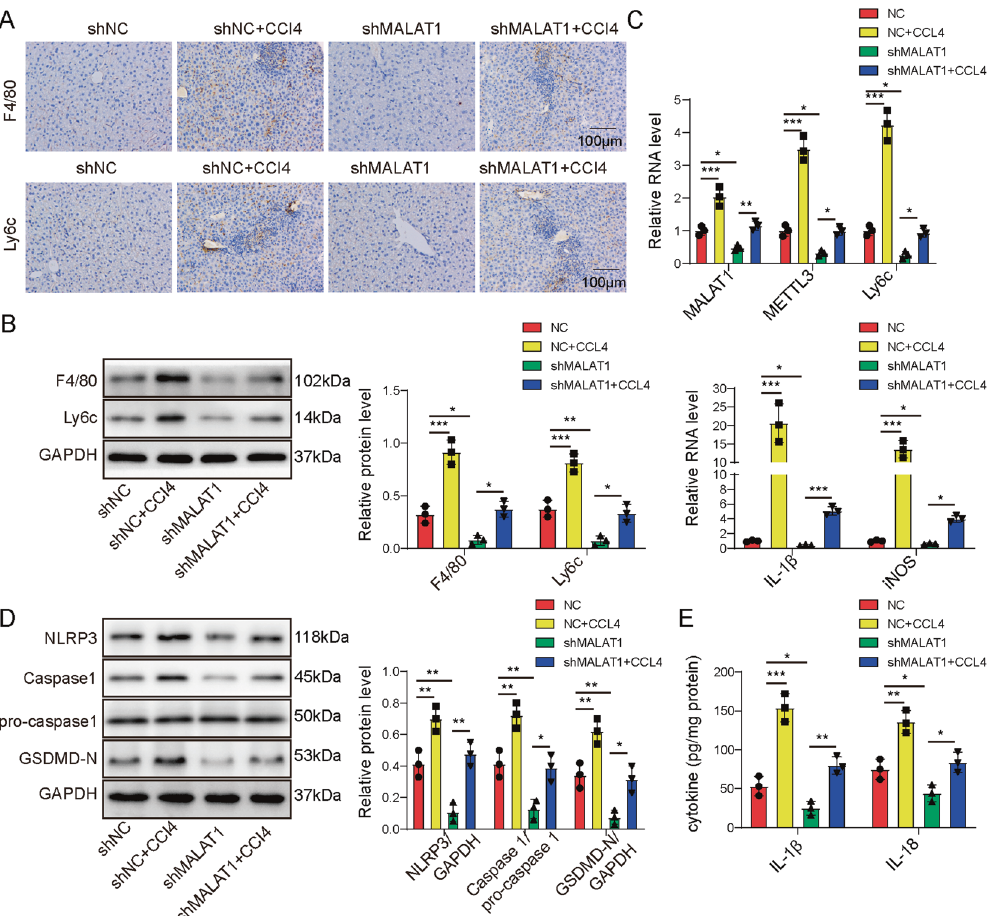
Fig. 2 Knocking down MALAT1 inhibited the activation of proin fl ammatory macrophages and NLRP3 in fl ammasome-induced pyroptosis. Mice were injected shNC, shMALAT1, CCl4 in combination with shNC (shNC + CCl4), or CCl4 in combination with sh-MALAT1 (shMALAT1 + CCl4) ( n = 10/group). Expressions of F4/80 and Ly6c proteins were detected by immunohistochemistry ( A ) and by western blot ( B ) in liver tissues from indicated groups. C The expressions of MALAT1, F4/80, Ly6c, IL-6, and iNOS were examined by RT-qPCR. D The expressions